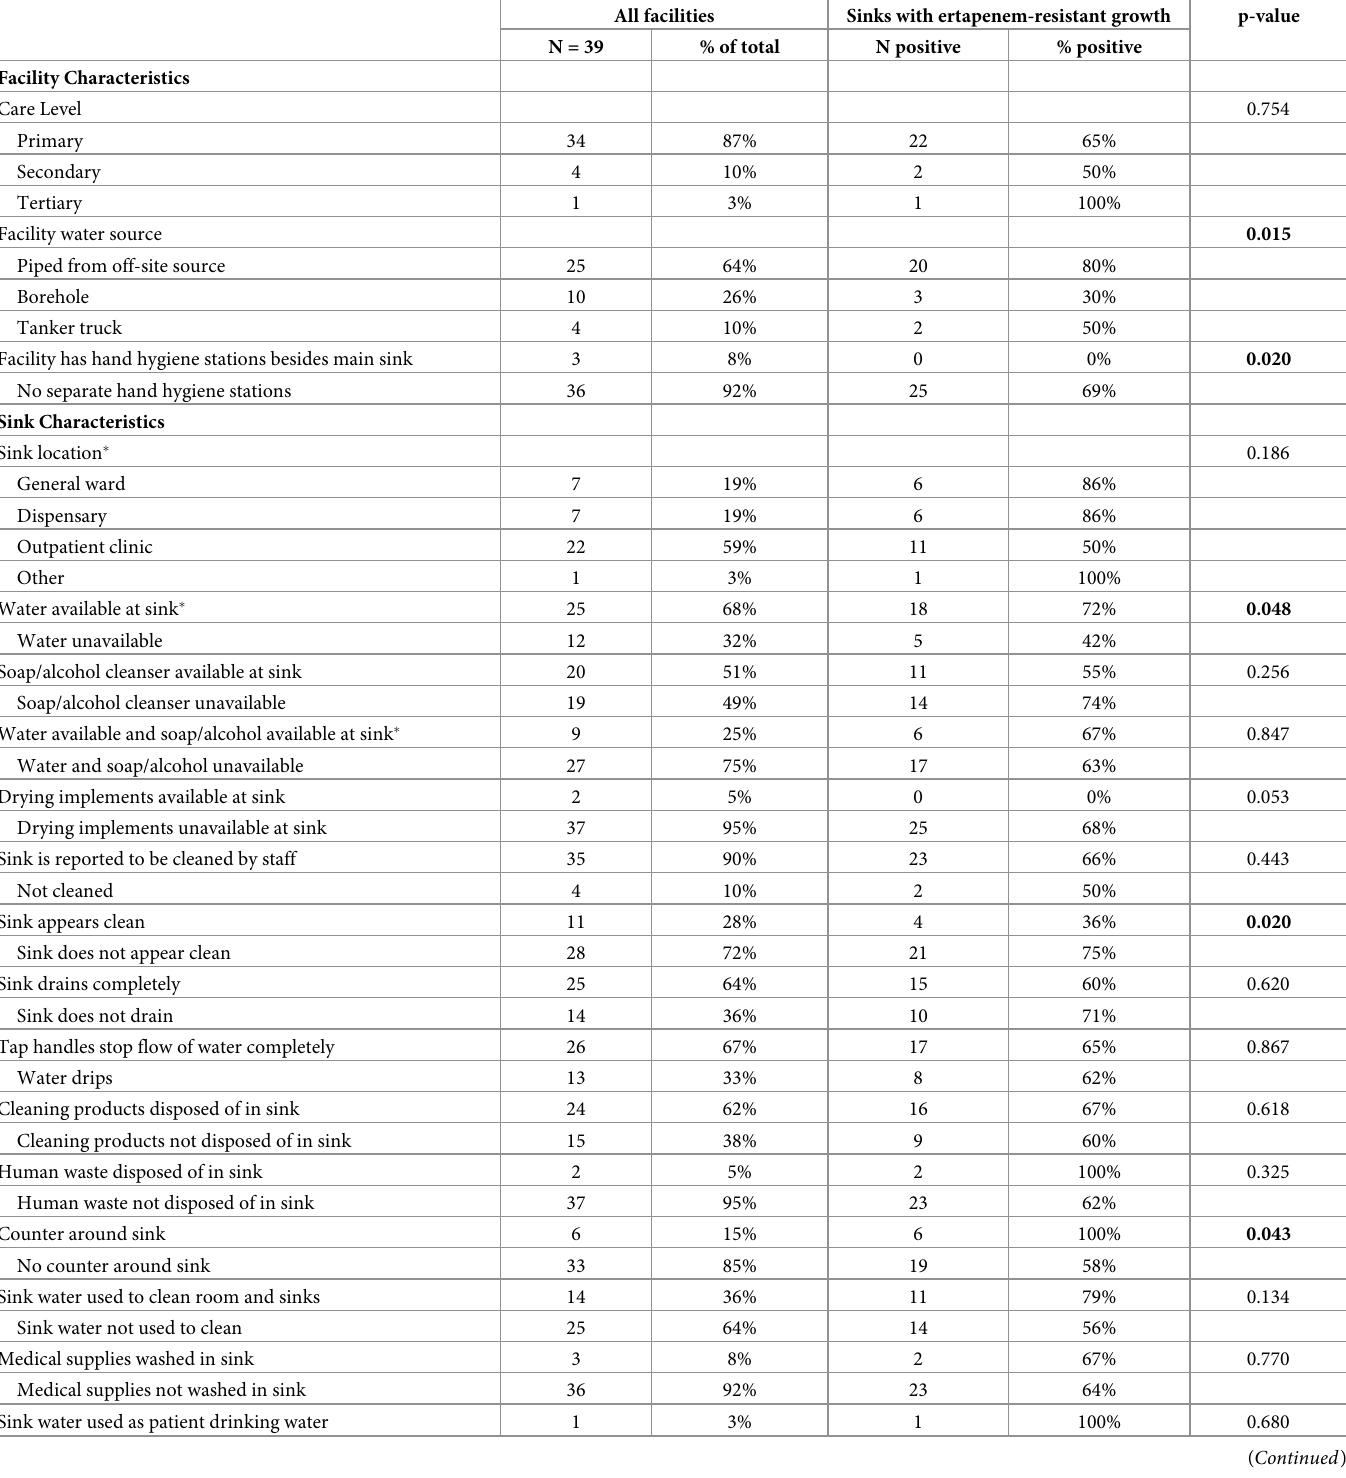
Table 2. Association between facility and sink characteristics and screening positive for carbapenem-resistant Enterobacteriaceae growth on CHROMagar KPC in 39 sinks from 37 healthcare facilities in Sindh